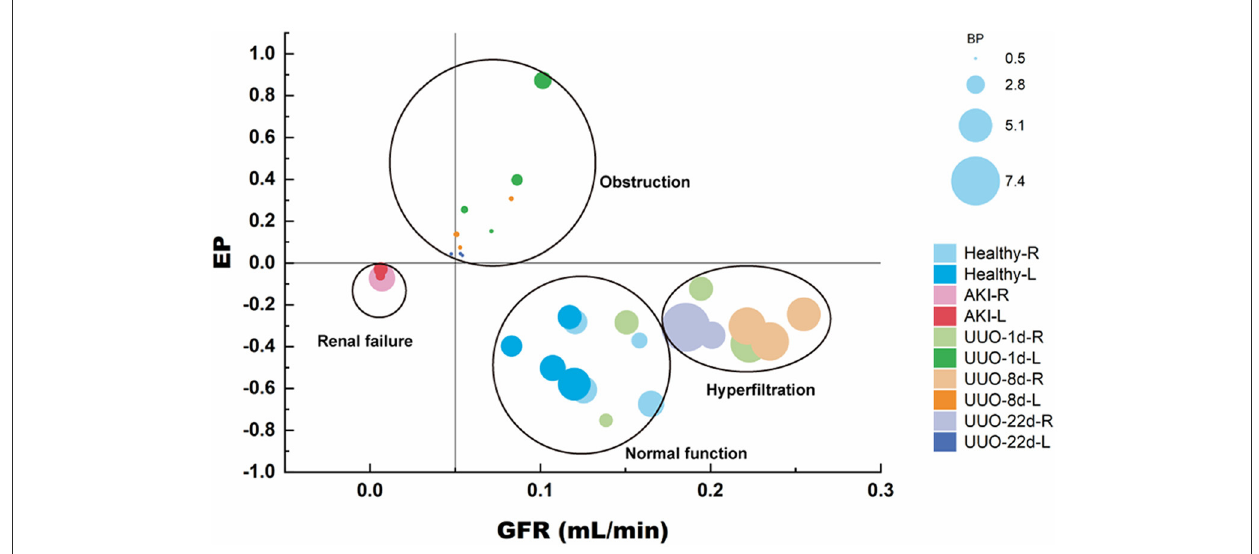
FIGURE7 Renal function evaluation on synthetic data as reflected/estimated by GFR PET .